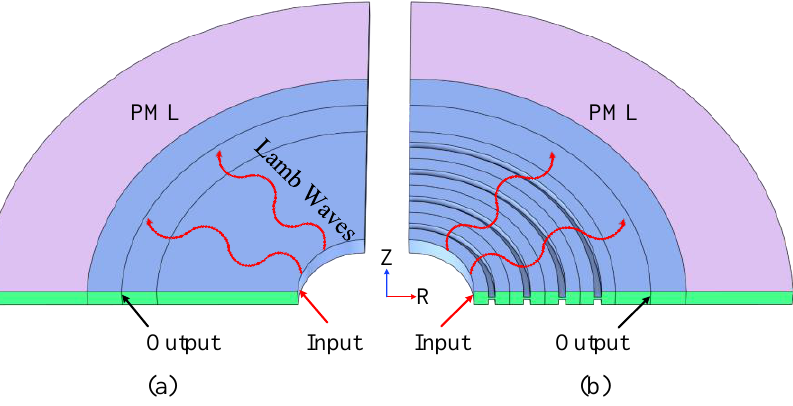
Figure 3. Frequency response model. ( a ) is a traditional model; ( b ) is a 4-period H-RPC model.